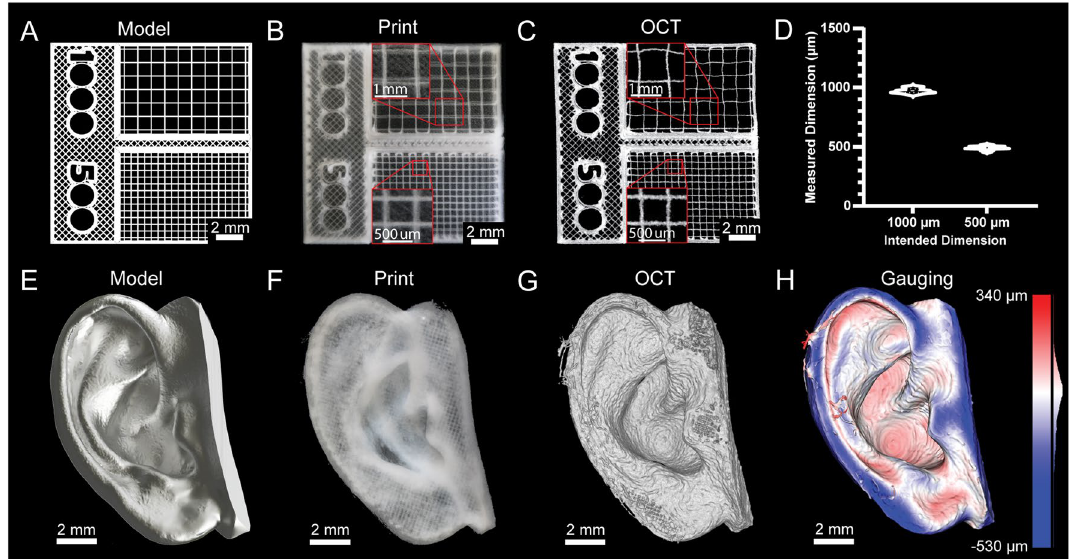
Figure 4. Printing dimensionally accurate grids and organic shapes. ( A ) Model of a gridded scaffold with 500 µm and 1000 µm grids. ( B ) Photograph of the gridded scaffold printed in collagen type I. ( C ) An OCT image of the gridded scaffold print. ( D ) Analysis of the accuracy of the gridded scaffold print (mean ± STD.; n = 11 measurements for 1000 µm grid, n = 26 measurements for 500 µm grid, p < 0.0001 [****] for 1000 µm compared to 500 µm by Student’s two-tailed, unpaired t-test). ( E ) A 3D model of an ear. ( F ) A photograph of the ear printed in collagen type I. ( G ) An OCT volumetric image of the printed ear. ( H ) Quantitative gauging of the ear print against the original 3D